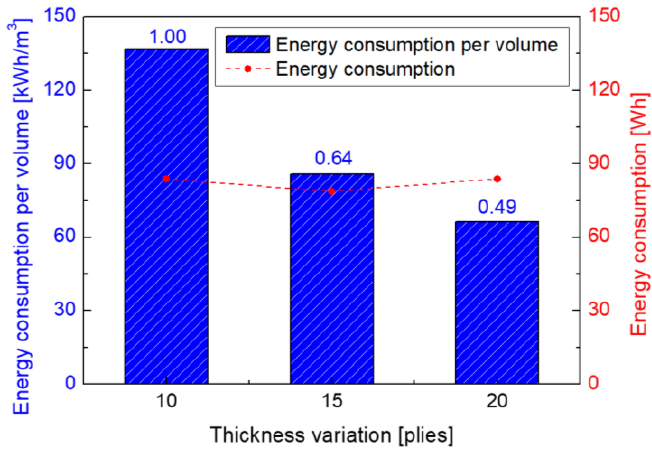
Figure 9. Energy consumption per volume with thickness change of composite.